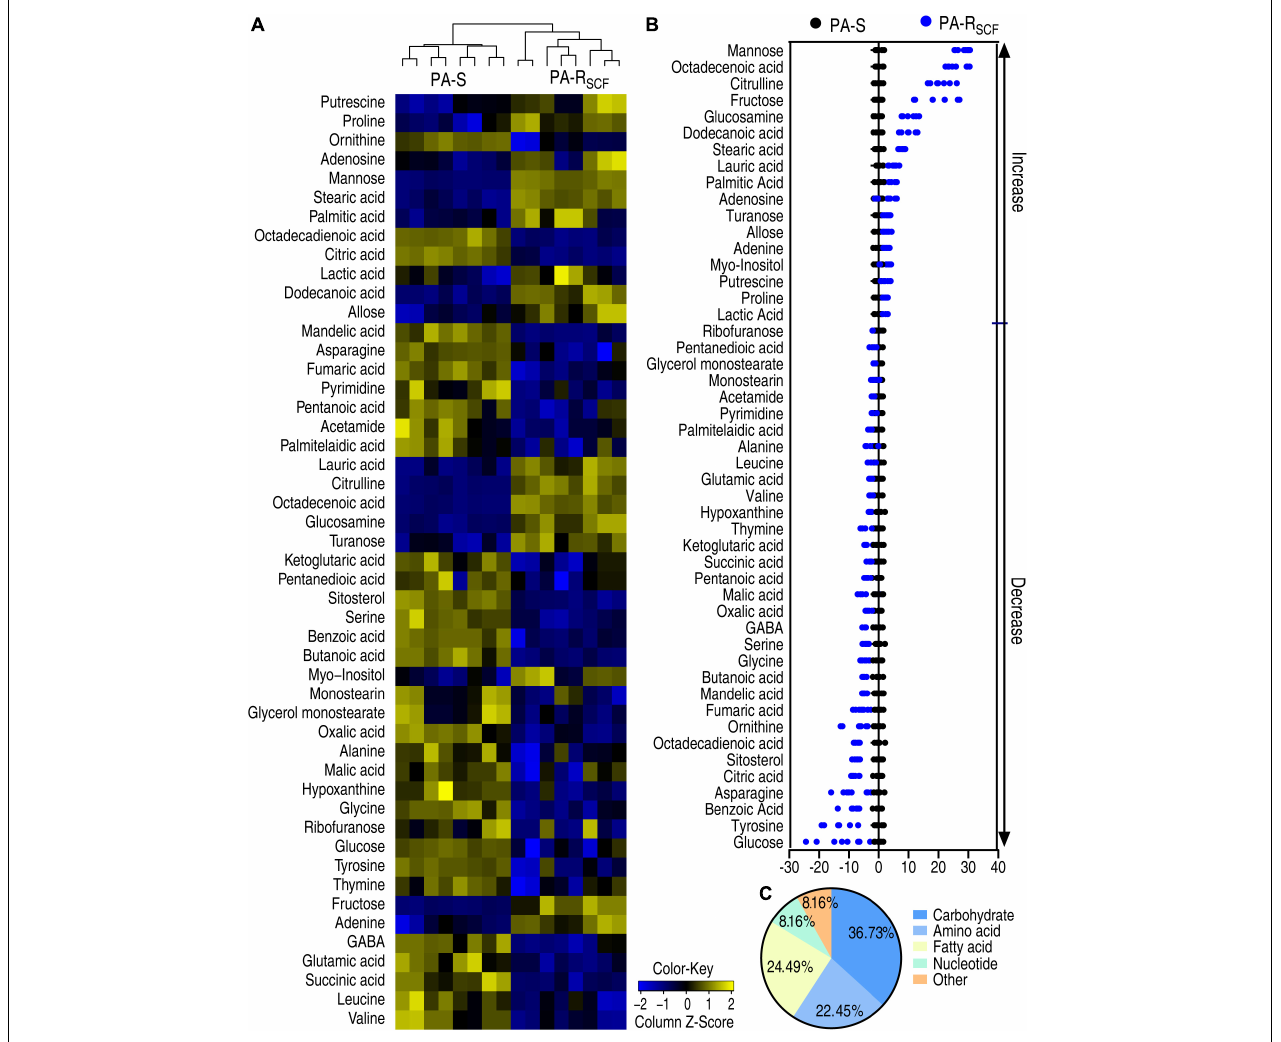
FIGURE 2 | Differentially metabolic profiles in PA-R SCF . (A) Heatmaps of differential abundance of metabolites in PA-S and PA-R SCF (row). Blue and yellow indicate lower and higher expression of the metabolites relative to the mean and standard deviation of the row metabolite level, respectively (see color scale). (B) Z -score plots of differential abundances of metabolites based on control. The data were separately scaled to the mean and standard deviation of the control (PA-S). Each point represents one metabolite in one technical repeat and colored by sample types. (C) Categories of differential abundance of metabolites in PA-S and PA-R SCF